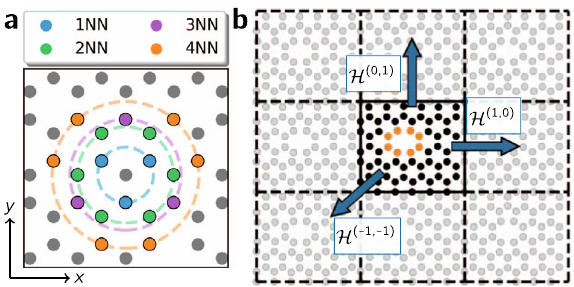
Fig. 1 Tight-binding model of graphene lattice. a Nearest- neighbor interactions in a hexagonal graphene lattice. The central gray atom has three fi rst nearest neighbors (1NN, dark blue), 6 second-nearest neighbors (2NN, green), etc. b Interaction of a defect supercell with its periodic images (defect region highlighted in orange). The center cell itself is described by H ð 0 ; 0 Þ , the interactions to its neighboring cells by H ð λ x ; λ y Þ --- for large supercells only the nearest-neighbor interactions between cells, i.e., λ x , λ y ∈ { − 1, 0, 1} are